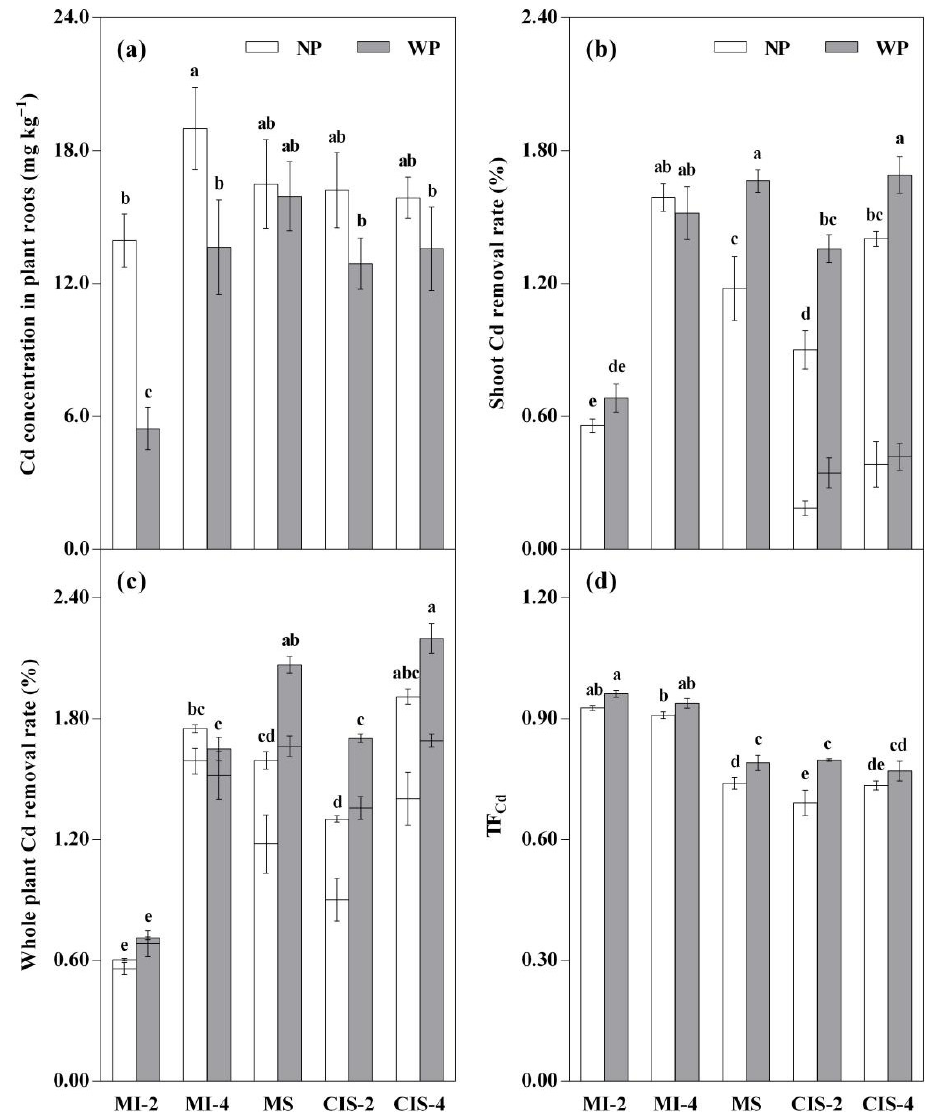
Figure 3. Effects of planting pattern and peat application on root Cd concentration ( a ), shoot Cd removal rate ( b ), whole plant Cd removal rate ( c ), and Cd translocation factor (TF Cd ) ( d ) of Indian mustard and/or silage maize plants. For explanation of treatment notations, see Table 2; data are expressed as means ± SD ( n = 3); the lower and upper parts of the stacked columns represent the shoot Cd removal rates of Indian mustard and silage maize plants, respectively ( b ) and the Cd removal rates by shoots and roots, respectively ( c ); different lowercase letters (e.g., a, b, c, etc.) indicate significant ( p < 0.05) differences among the treatments based on the Tukey test.